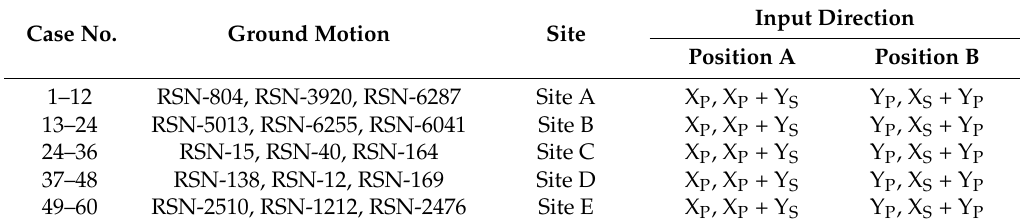
Figure 7. Relative position of model bridge and principal ground motion direction. ( a ) Position A, curved bridge parallel to the principal seismic direction. ( b ) Position B, curved bridge perpendicular to the principal seismic direction. Table 5. Test cases for different sites.